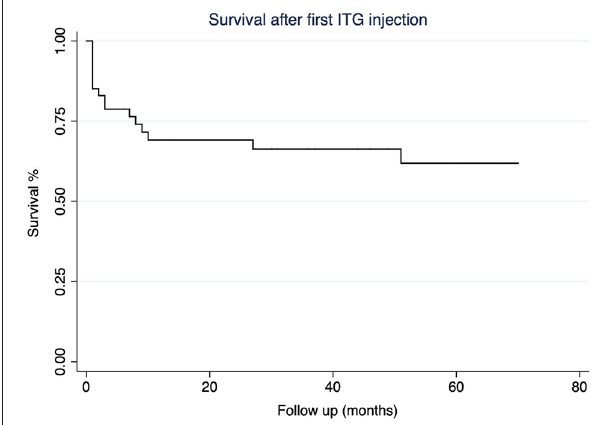
FIGURE 1 | The Kaplan-Meier survival curve according to the necessity for a second intratympanic gentamicin (ITG) injection.